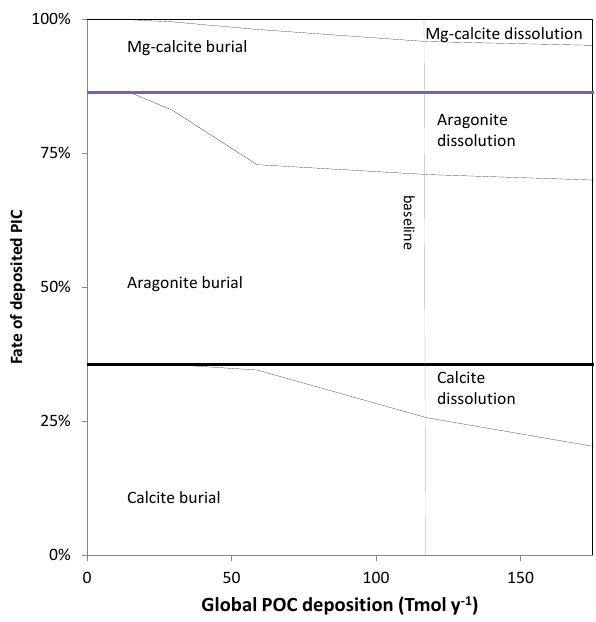
Fig. 8. Fate of PIC. Global dissolution or burial of CaCO 3 phases as a function of POC